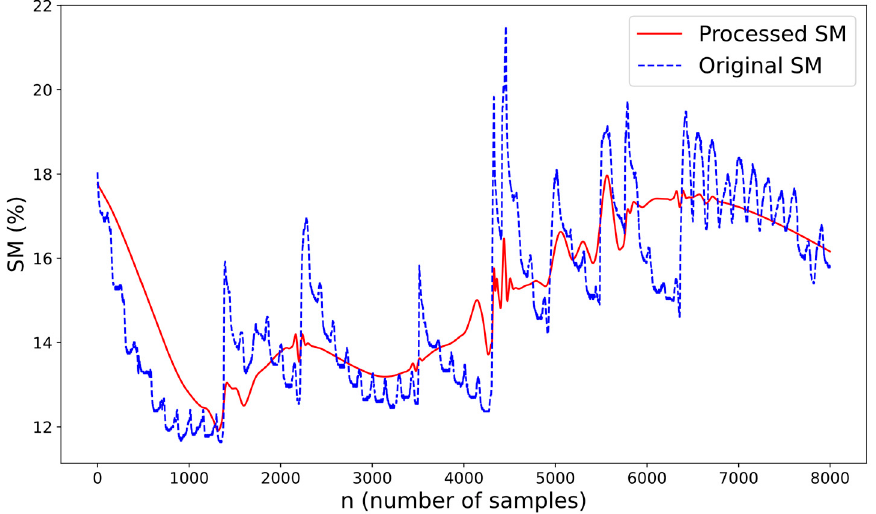
Figure 5. Results of the wavelet denoising of the soil moisture. Table 1. Statistical analysis results of original and processed soil moisture data.